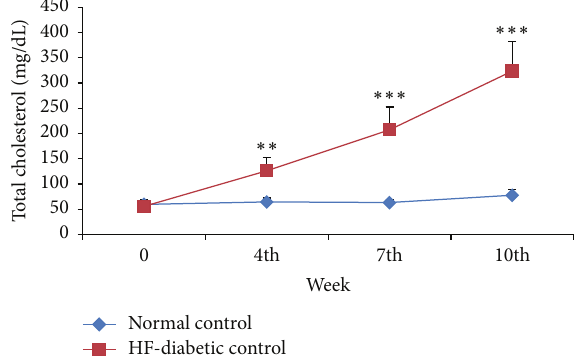
Figure 1: Rats of the Normal Control and High Fat Diabetic control groups at 10th weeks.